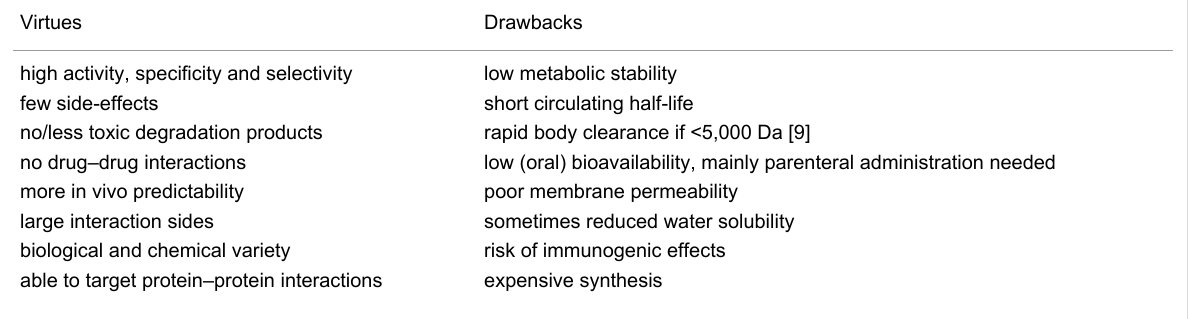
Table 1: “Drugability” attributes of peptide therapeutics compared with small molecules. Virtues